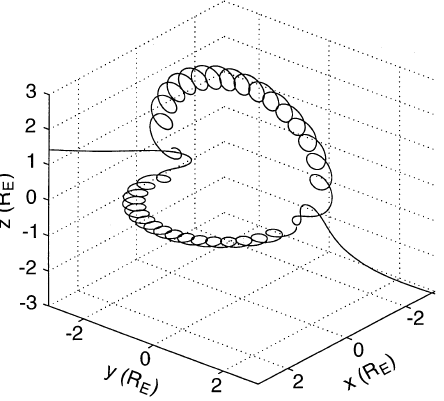
Fig. 4. Planar equatorial (3 MeV) and meridional (1 MeV) trajectories of a proton in an anti-symmetric sectorial quadrupole magnetic field ( m (cid:136) 1, n (cid:136) 2; g 21 (cid:136) 3058 nT, h 2 1 (cid:136) ) 2278